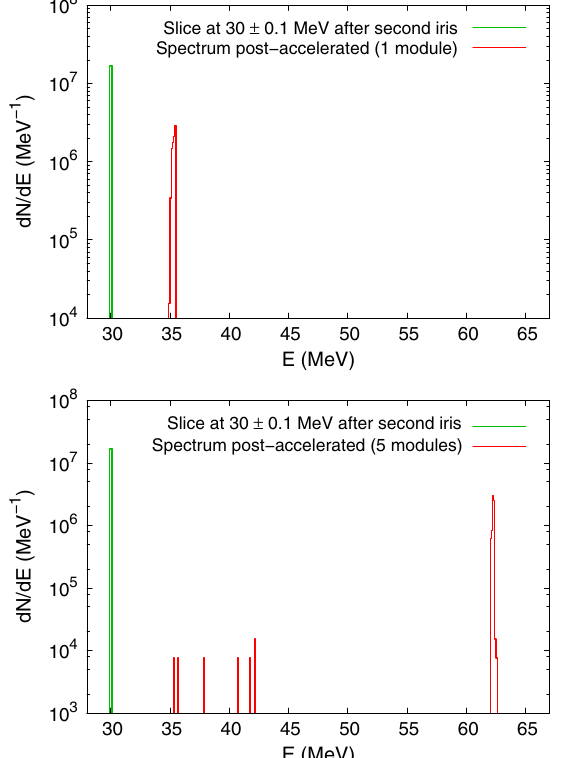
FIG. 10. Upper frame: Plot in a logarithmic scale of the proton energy spectrum after postacceleration by five modules of ACLIP (red curve) for the composite target foam þ foil (TNSA) compared with the spectrum after the second collimator (dark green curve). Lower frame: Plot of the energy-angle distribution after postacceleration in a logarithmic color scale.